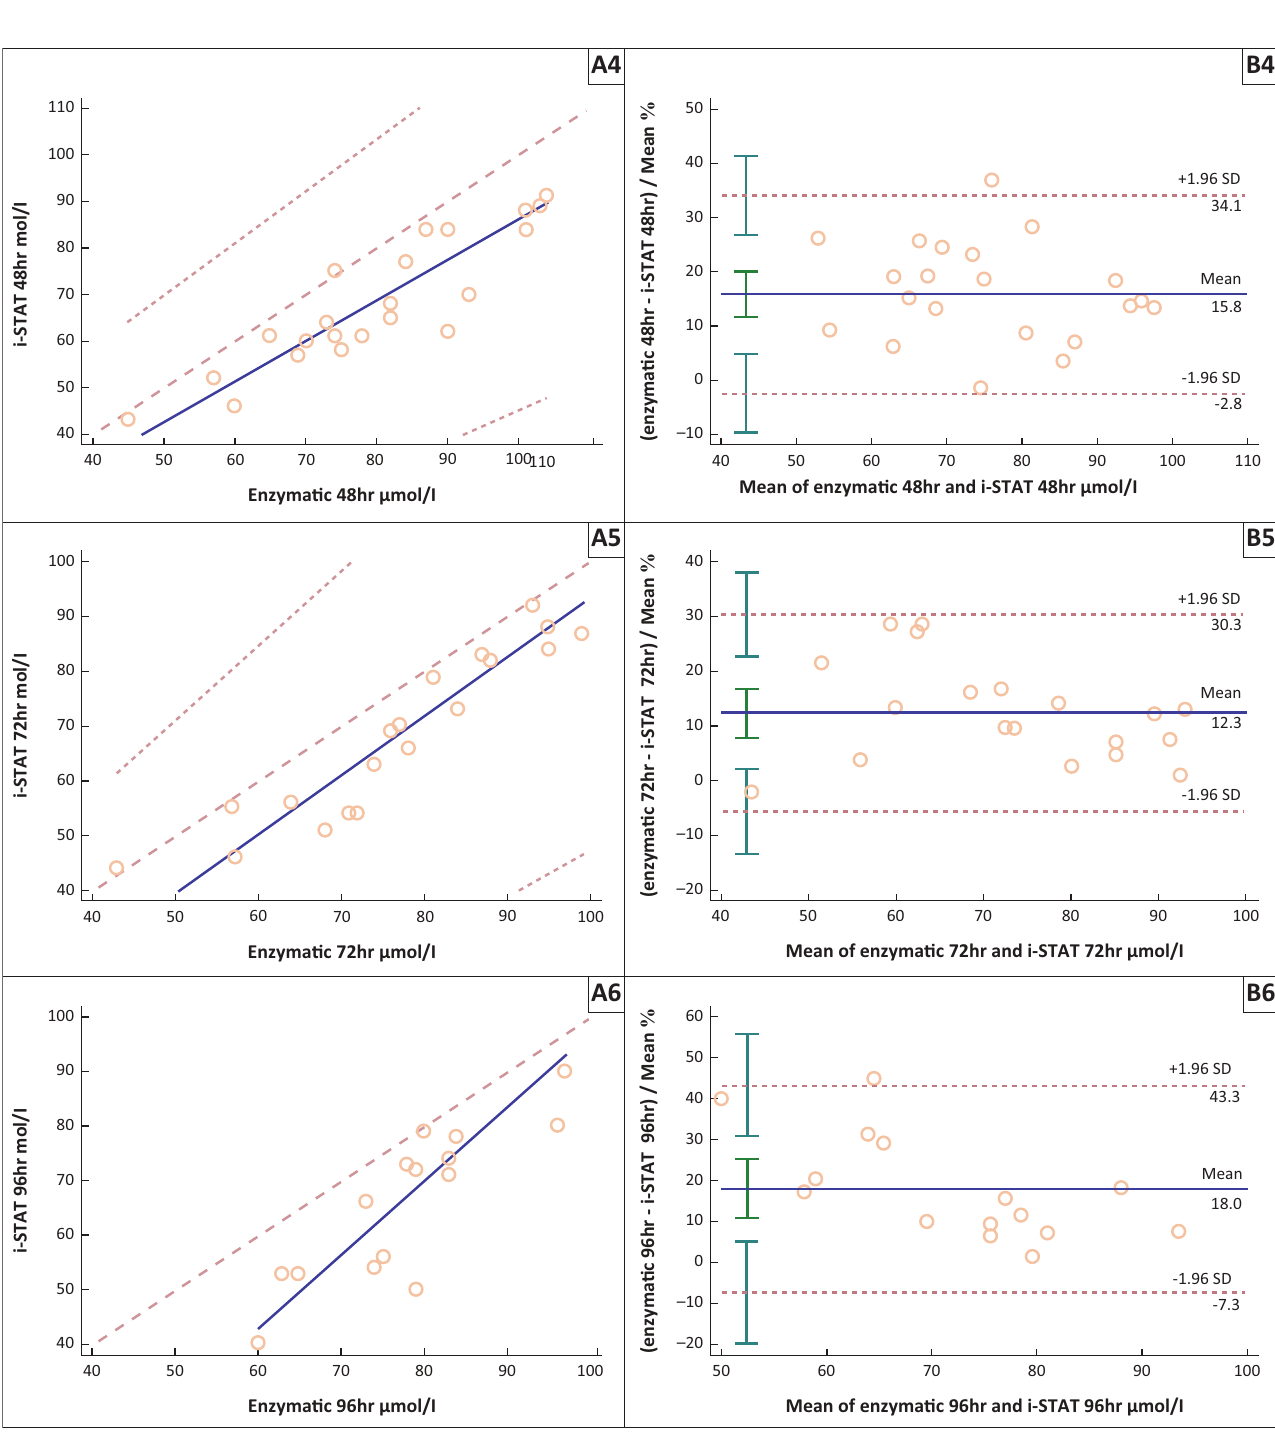
FIGURE 4 (Continues...): Passing-Bablok regression curves (A) and Bland-Altman plots (B) comparing creatinine concentrations from the i-STAT device with those obtained from the enzymatic method. Creatinine concentrations at (1) < 4 h, (2) 6 h, (3) 24 h, (4) 48 h, (5) 72 h and (6) 96